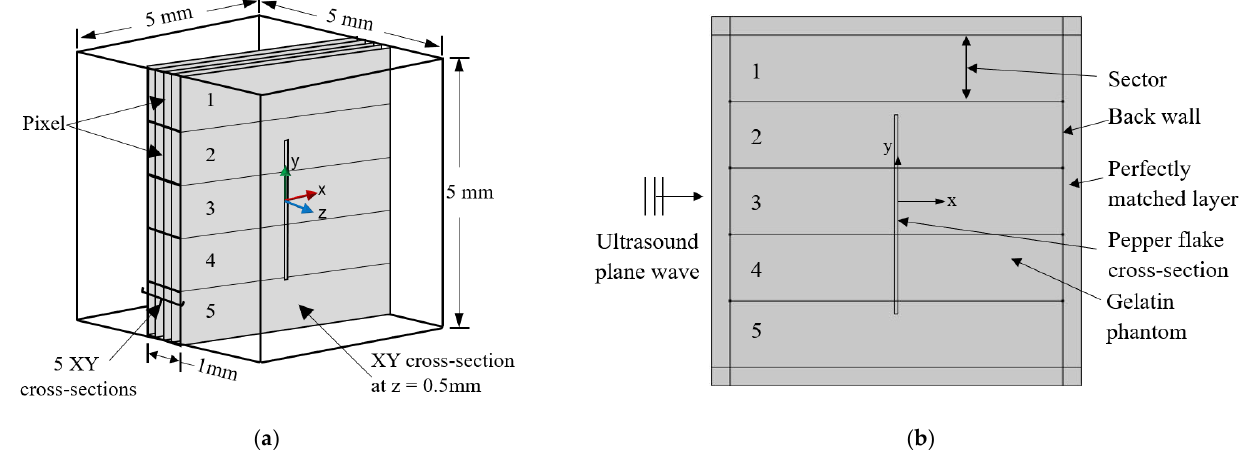
Figure 2. ( a ) Three-dimensional (3D) model with simplification details; ( b ) simplified 2D XY plane (at Z = 0).